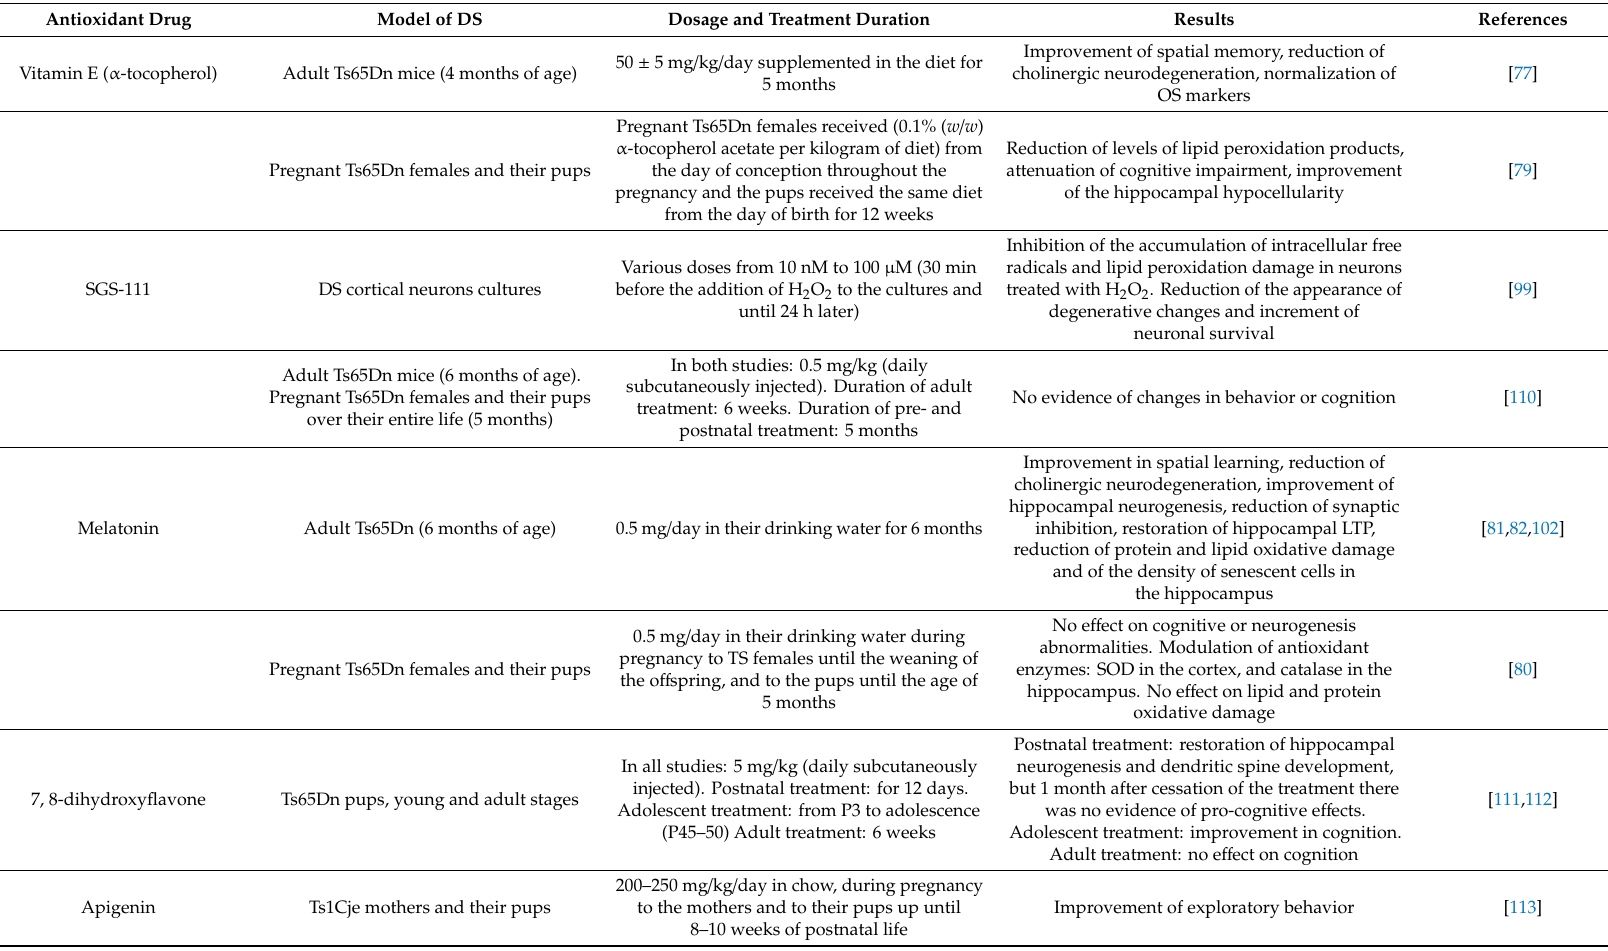
Table 1. Preclinical studies that assessed the e ffi cacy of natural and synthetic molecules with antioxidant properties in cellular and murine models of Down syndrome